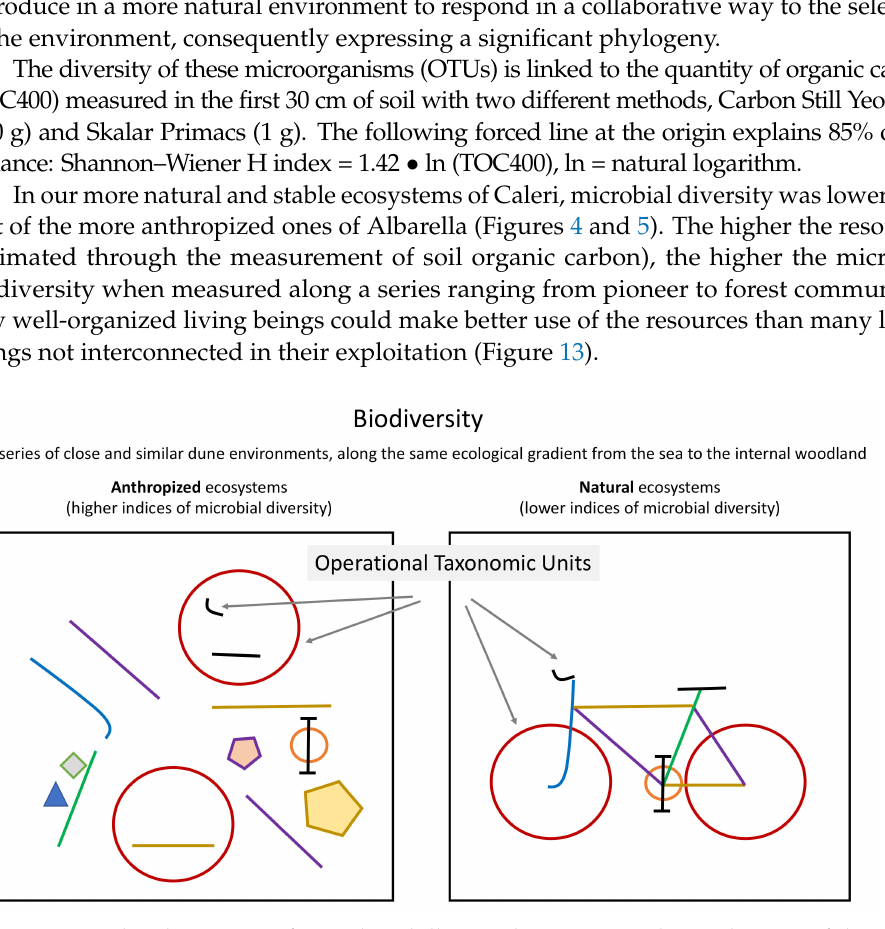
Figure 13. Modest honorary gift to John Phillips and Lynn Margulis, with a grateful smile to James